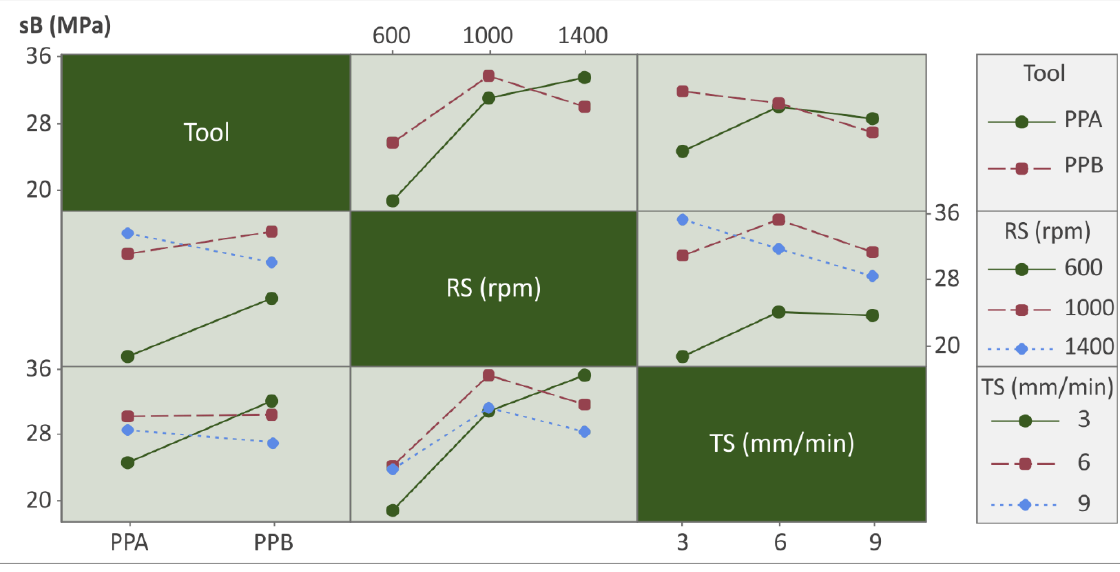
Figure 14. Interaction chart: Tool, RS, and TS vs. WT. The trend lines between rotational speed and travel speed versus modulus of elastic- ity increased smoothly without changing their directions. Furthermore, the same trends were observed for the rotational speed and Tool and the travel speed and Tool versus modulus of elasticity (Figure 12), indicating that the linear models with cross products or the quadratic regression models (QRM) will be appropriate for modeling the E versus Tool, rotational speed, and travel speed variable parameters. Figure 13 shows interactions of all input parameters versus Tensile strength (sB/MPA). In this case, the trend lines were slightly more complex, leading in some cases to a smooth change of direction. So, non-linear models such as quadratic regression mod- els are proposed in this case. Finally, interaction trend lines between all input parameters versus weld tempera- tures were in similar directions with synergistic interactions, meaning that linear or quad- ratic regression models will be appropriate for fitting the observed experimental data (see Figure 14).